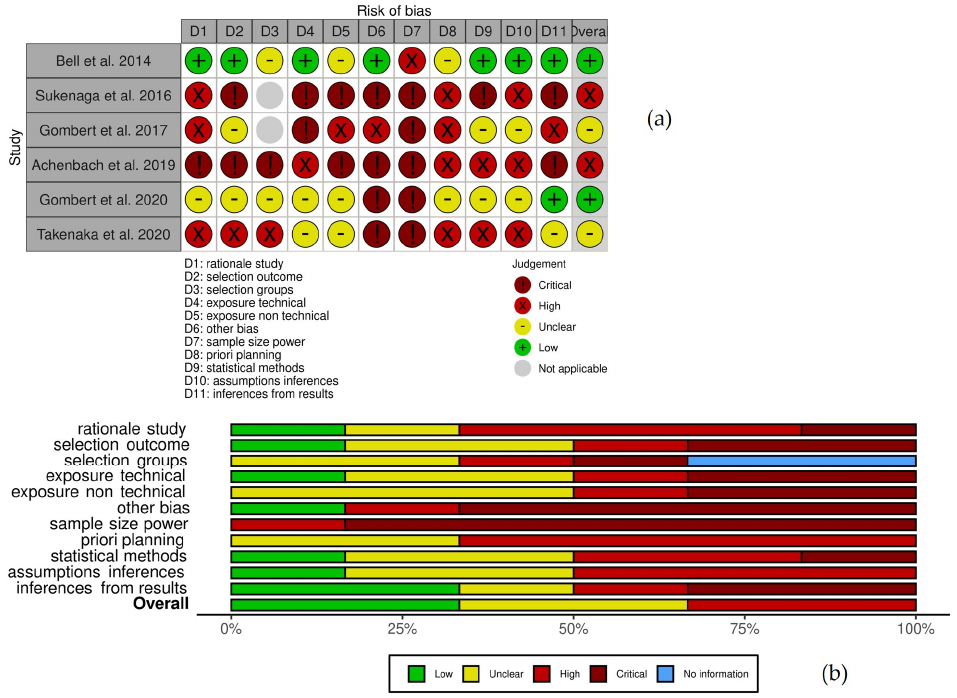
Figure 2. Evaluation of the risk of bias using the Q-Genie tool and presented as single and aggregated results. ( a ) risk of bias in each separated study presented for each single item, and overall (last column, Overall). ( b ) Aggregated results for every single item describing the risk of bias for the studies examined.